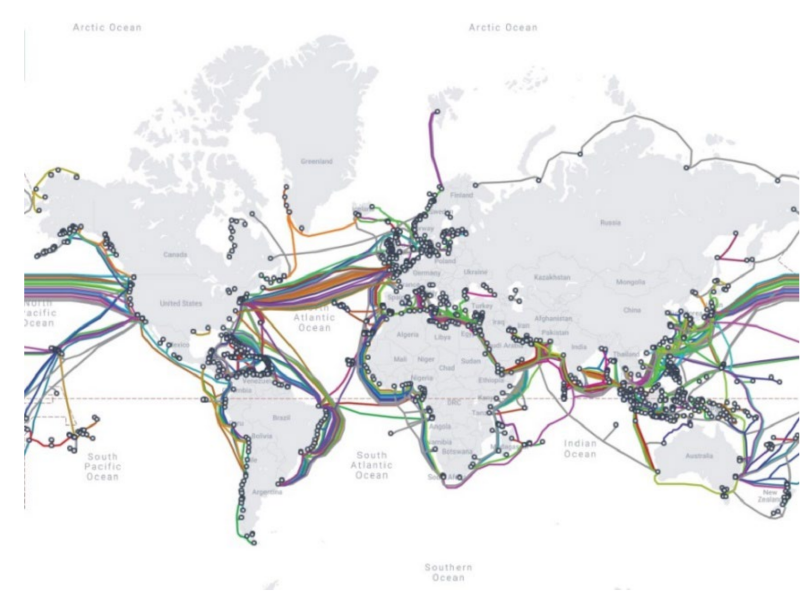
Figure 3. Submarine worldwide cable map [2].